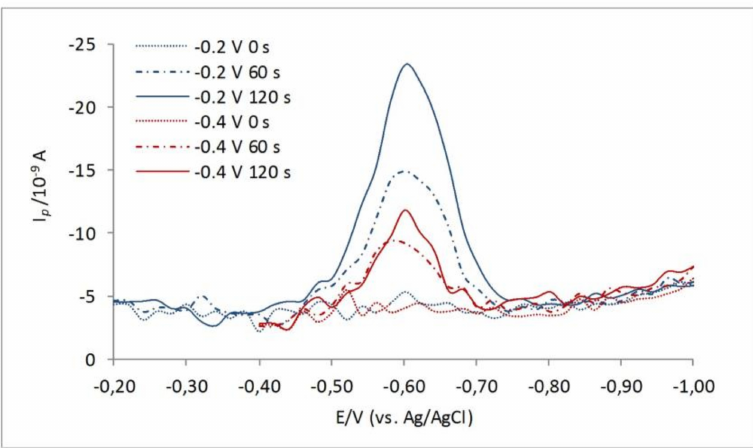
Figure 2. E ff ect of di ff erent deposition potentials, E d = − 0.2 V (red lines), and E d = − 0.4 V (blue lines) and di ff erent accumulation times for electrolyte solution containing 9 nM 3-MPA. Experimental conditions: A = 25 mV; f = 80